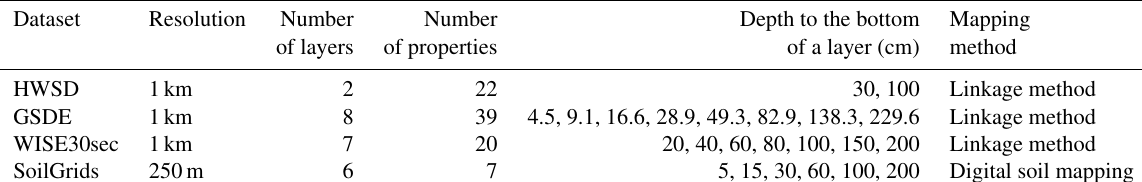
Table 2. Four new global soil datasets for ESM updates.